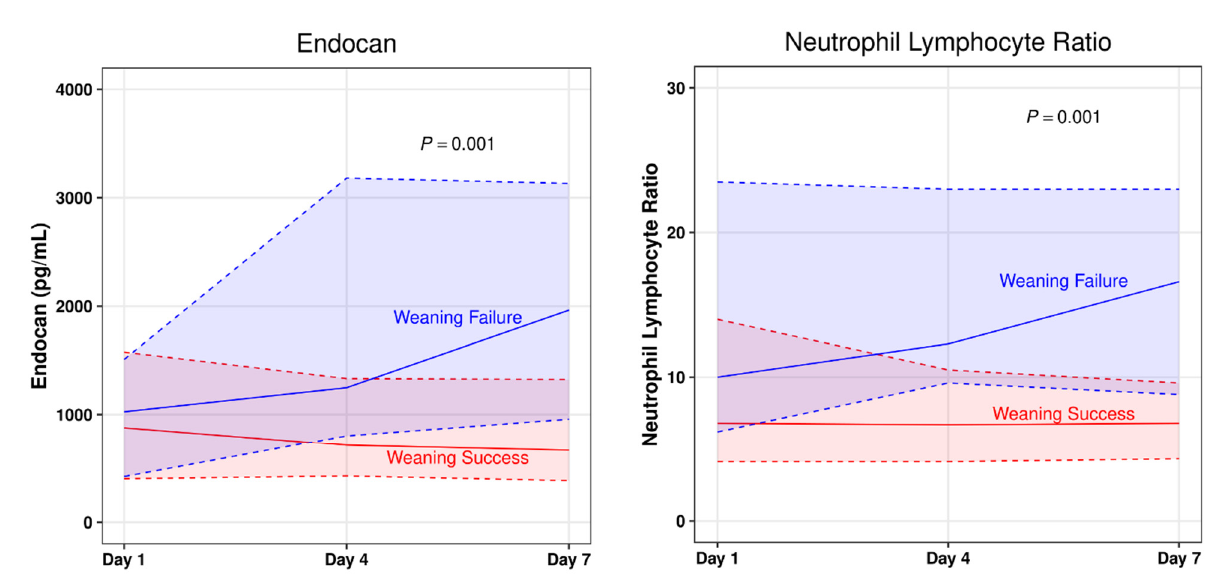
Figure 1. Plasma endocan levels and neutrophil lymphocyte ratios during the 7-day study period. Solid lines represent median values, and the shaded areas bordered by dotted lines represent upper and lower quartiles. The AUCs were compared between groups using the Mann-Whitney U test. AUC: area under the curve. 3.3. Predictors of Weaning Failure When comparing clinical variables and laboratory parameters between the weaning failure and success groups, nine biomarkers were significantly different within the uni- variable analyses, including qSOFA score, SpO 2 /FiO 2 , PCT, D-dimer, Ang-2, Ang-2/Ang- 1, endocan (4-day and 7-day increases), and TNF- α (Tables 1 and 2). These nine bi- omarkers were selected to construct a prediction model for weaning failure (Table 3). The 7-day increase in endocan (AUC: 0.81, 95% confidence interval, 0.67–0.94; p < 0.001) was the best predictor when compared with SpO 2 /FiO 2 , SOFA score, PCT, and D-dimer (Figure 2). The optimal cut-off for the 7-day increase in endocan (to predict weaning failure) was 292.53 pg/mL based on Youden’s index, with a 78% sensitivity and 79% specificity. Cu- mulative weaning failure assessed by a Kaplan-Meier curve with a cut-off of 292.53 pg/mL demonstrated a distinct separation between the groups (Figure 3); 61% (14/23) of patients with a 7-day increase in endocan of ≥ 292.53 pg/mL failed to be liberated from oxygen therapy at day 28, whereas only 12% (4/33) of patients with endocan <292.53 pg/mL failed. Models for predicting weaning failure through other biomarkers are described in Table S2. Table 3. Models for predicting failure of liberation from oxygen therapy at day 28 following hospital admission through the top nine performing biomarkers.